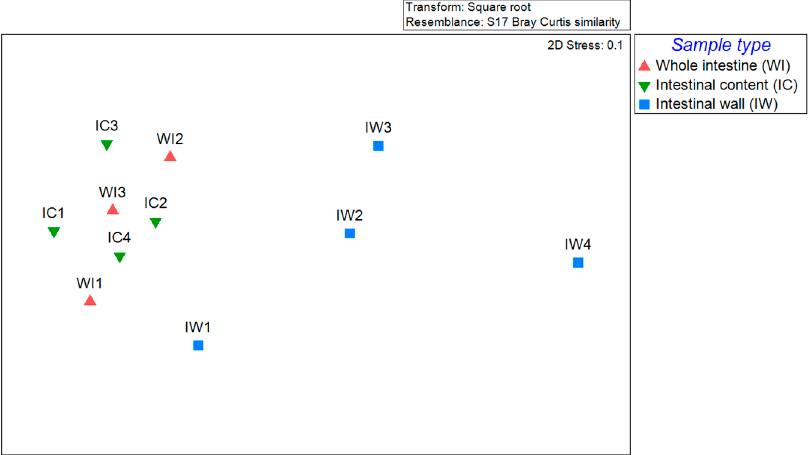
Figure 2. Non-metric multidimensional (nMDS) plot showing Bray–Curtis distances between the gut microbiome samples of wild C. gunnari .